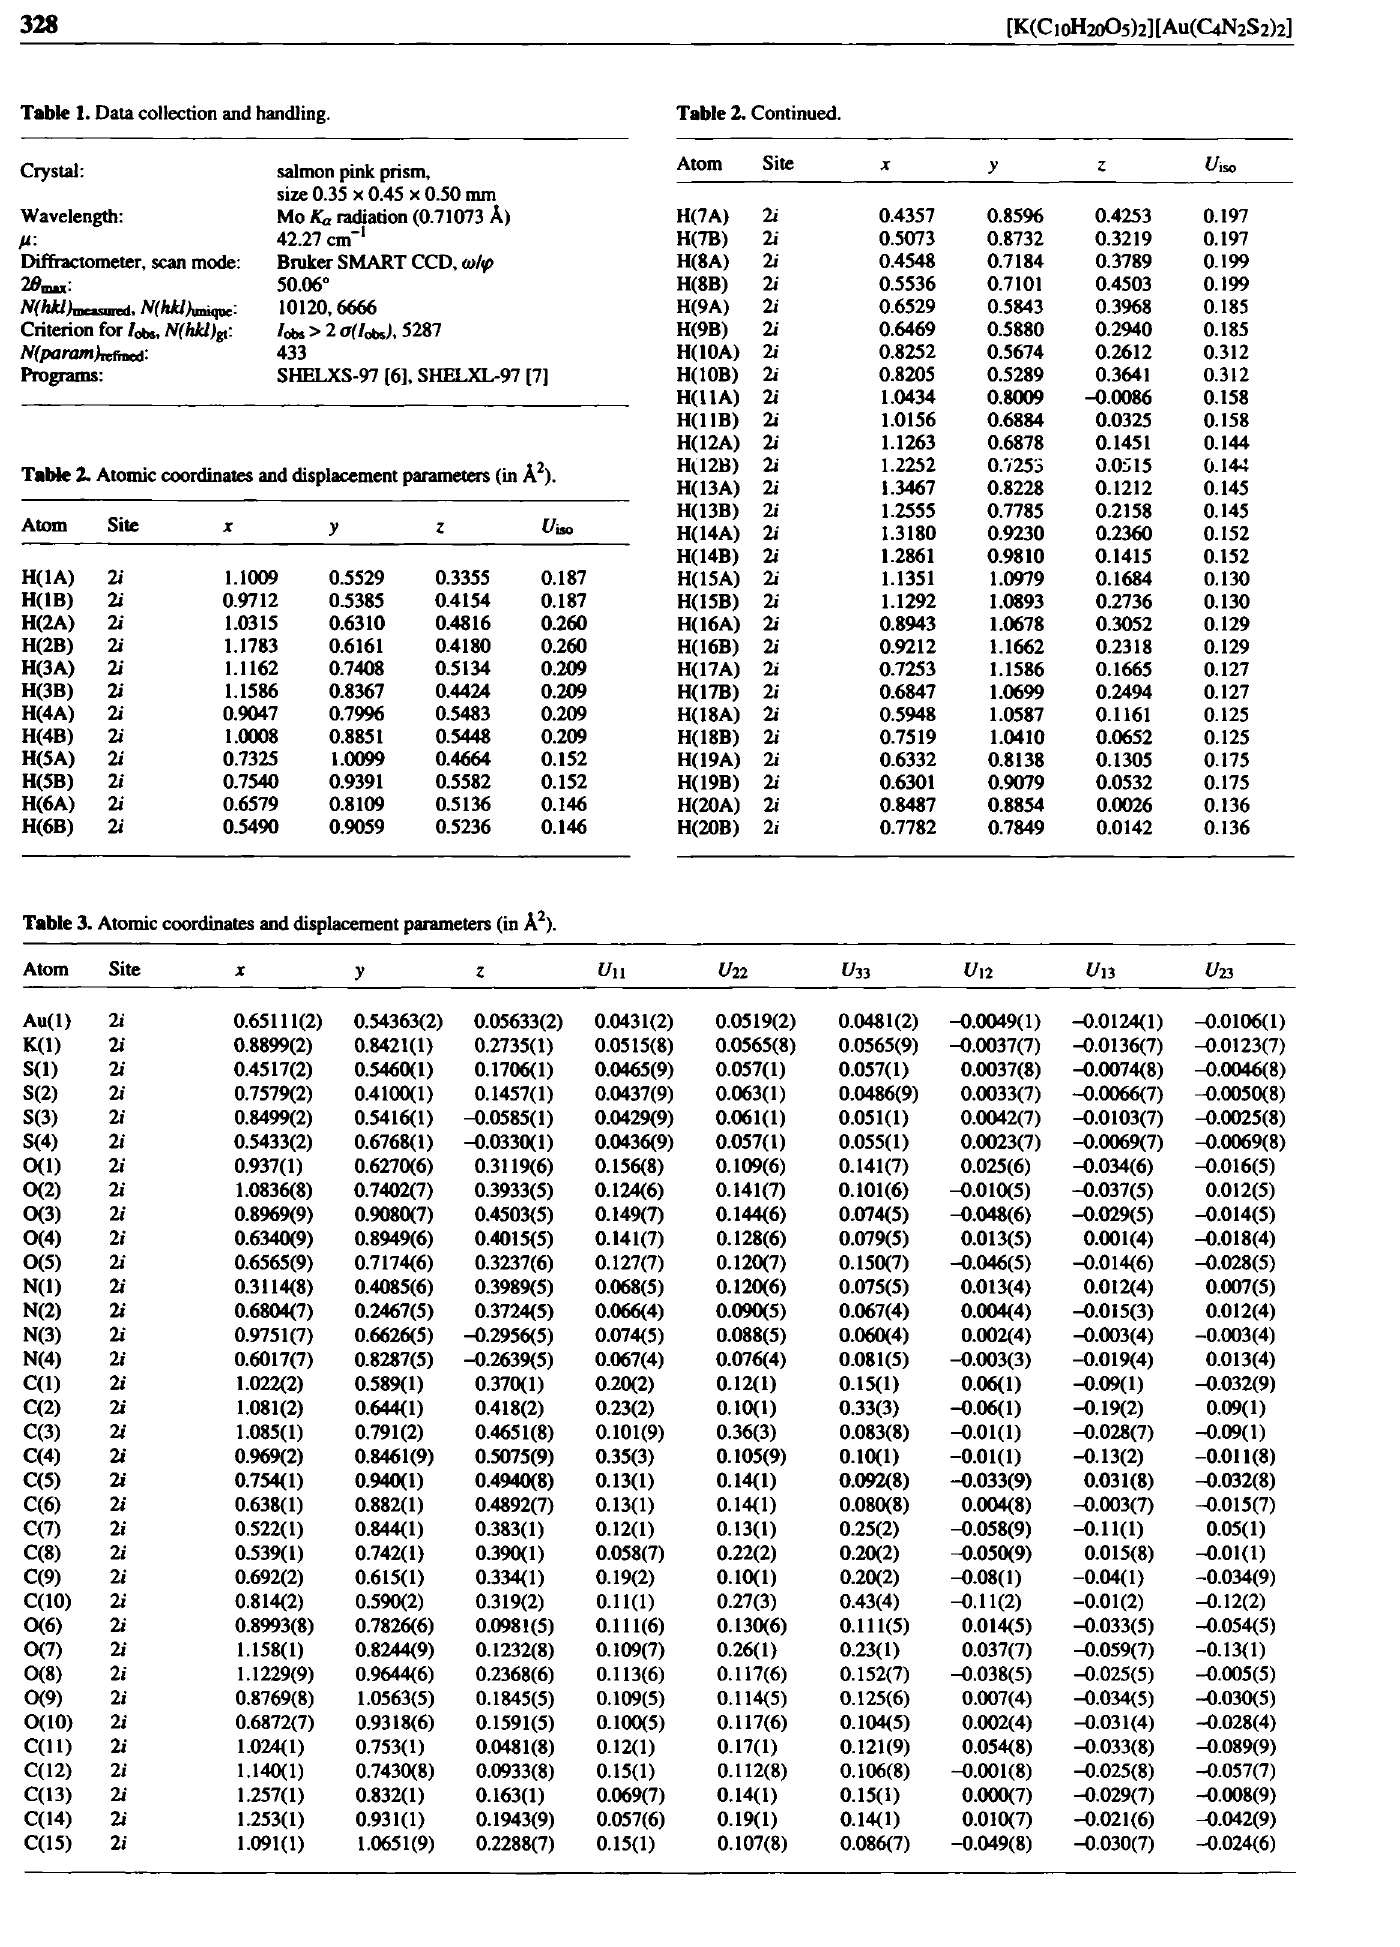
Table 1. Data collection and handling. Table 2. Continued.